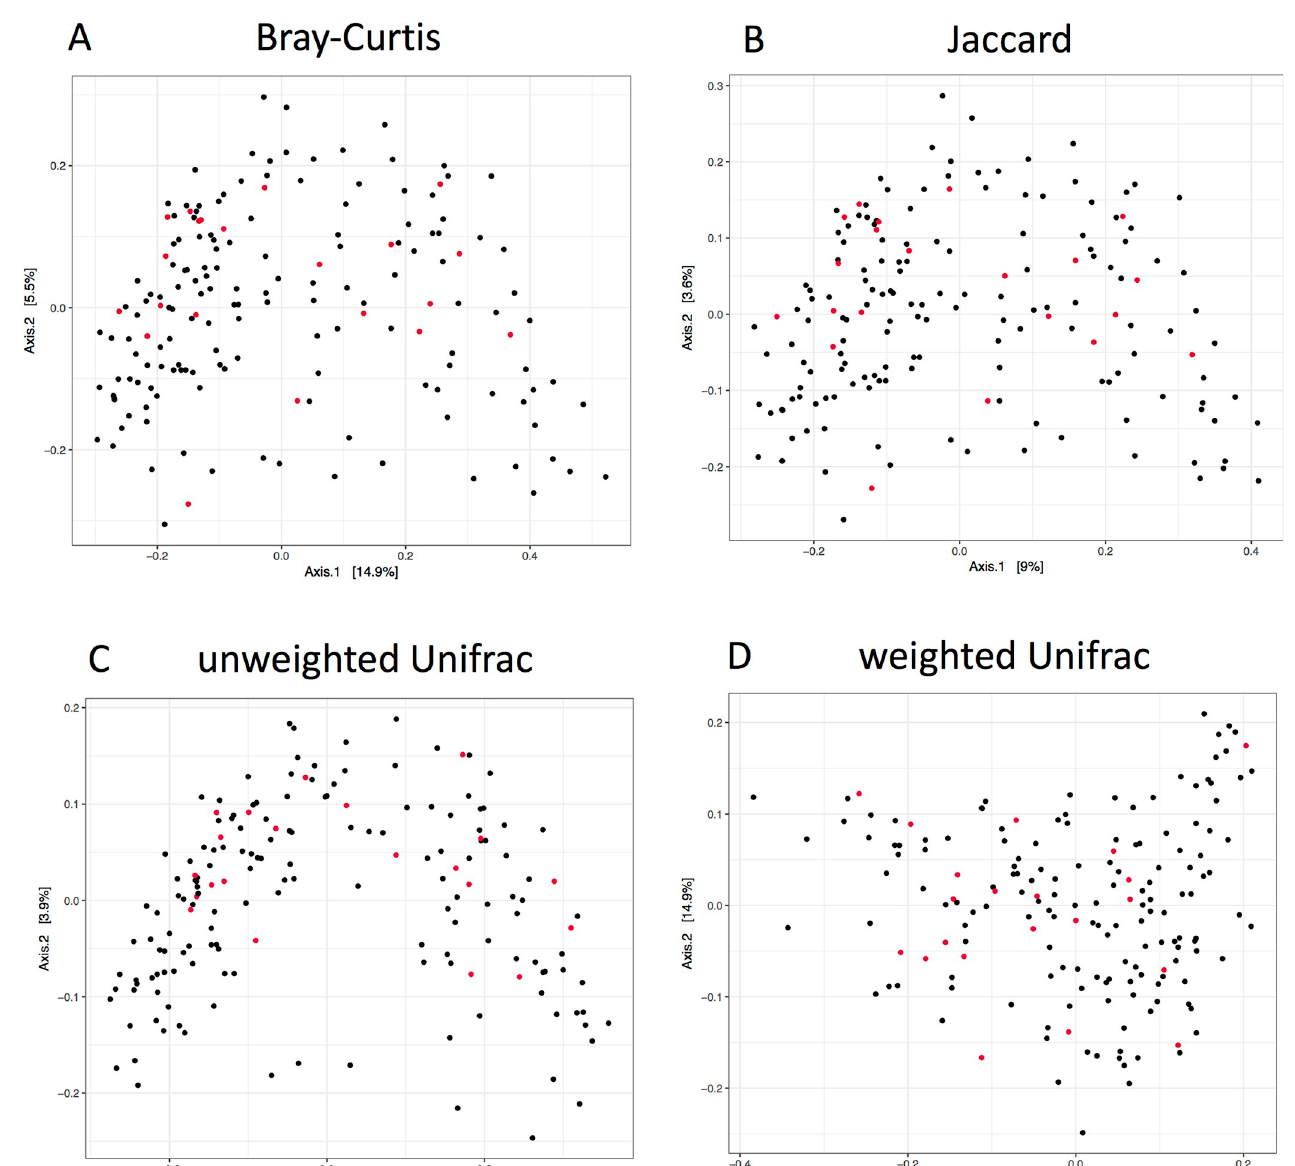
Fig 1. Beta diversity within Crohn’s disease by using four methods. Principal coordinate analysis of gut microbiome composition generated using 16S rRNA sequencing of stool samples of 171 patients with CD. Depicted are four different methods to identify the beta diversity of these samples: A) Bray-Curtis distances, B) Jaccard, C) unweighted Unifrac and D) weighted Unifrac. The 21 SLC39A8 [Thr]391 risk carriers are shown by red dots and 150 non-carriers by black dots. There was no statistically significant association between the SLC39A8 [Thr]391 risk allele and beta diversity identified in CD, nor in the different methods